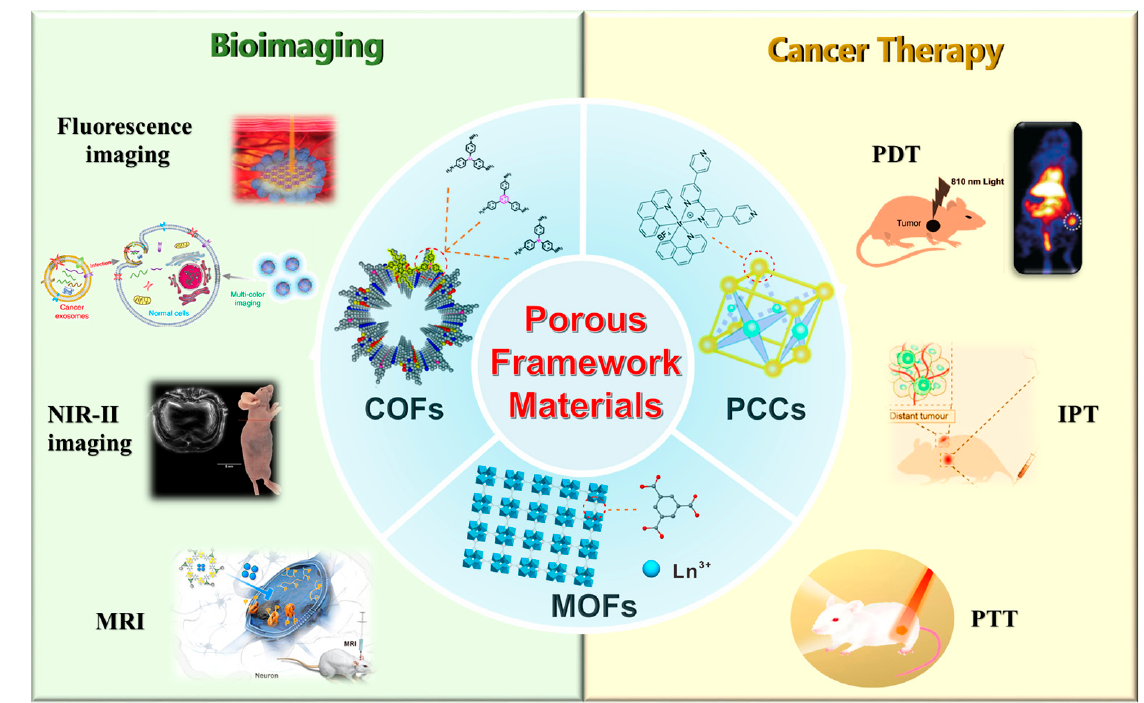
Scheme 1. Porous framework materials in bioimaging and cancer therapy. Table 1. Recent advances in porous framework materials for bioimaging and cancer therapy. Applications